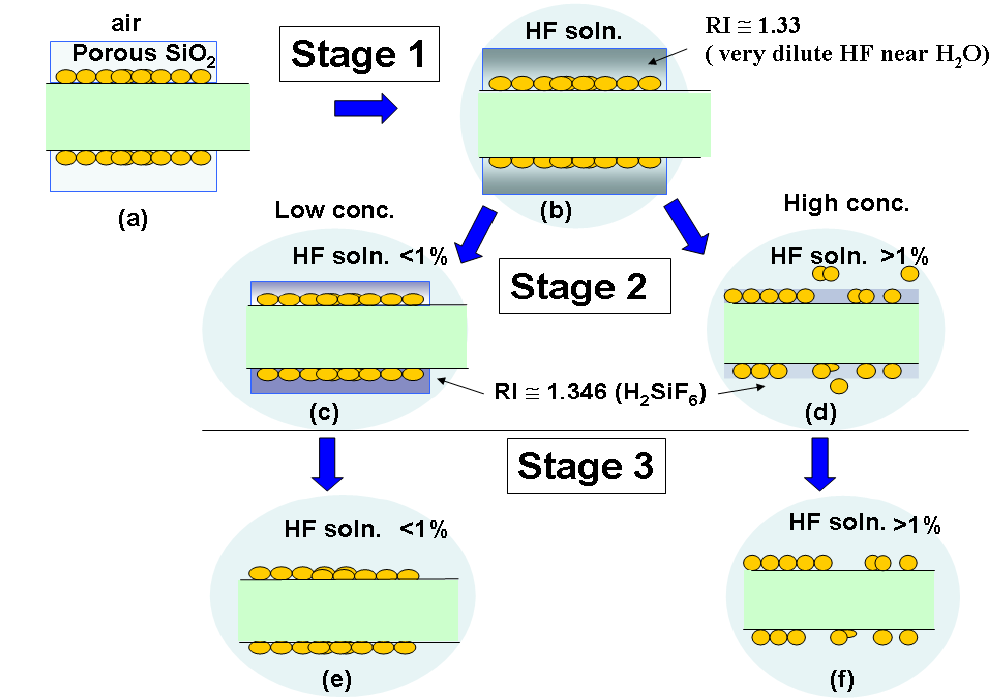
Figure 6. The stages of sensing mechanism of SiO /LSPR sensing probe in the HFsolution. 2 Stage-1: SiO porous layer was filled with solution (a~b). Stage-2: SiO layer was eroded 2 2 and produced H SiF (H SiF would deposit in the inner surface of porous layer: c~d). 2 6 2 6 Stage 3: SiO was completely eroded (e~f). Yet the twofold effects of HF concentrations on 2 SiO layer would induce different mechanisms to influence Relative RI Change Rates. One 2 was the excessive accumulation of H SiF in the porous structure (b  c  e) when HF 2 6 concentration was less than 1%, and the other was the loss of attachment of NM on Au PMMA optical fibers (b  d  f) when HF concentration was more than 1% ( please see the text )